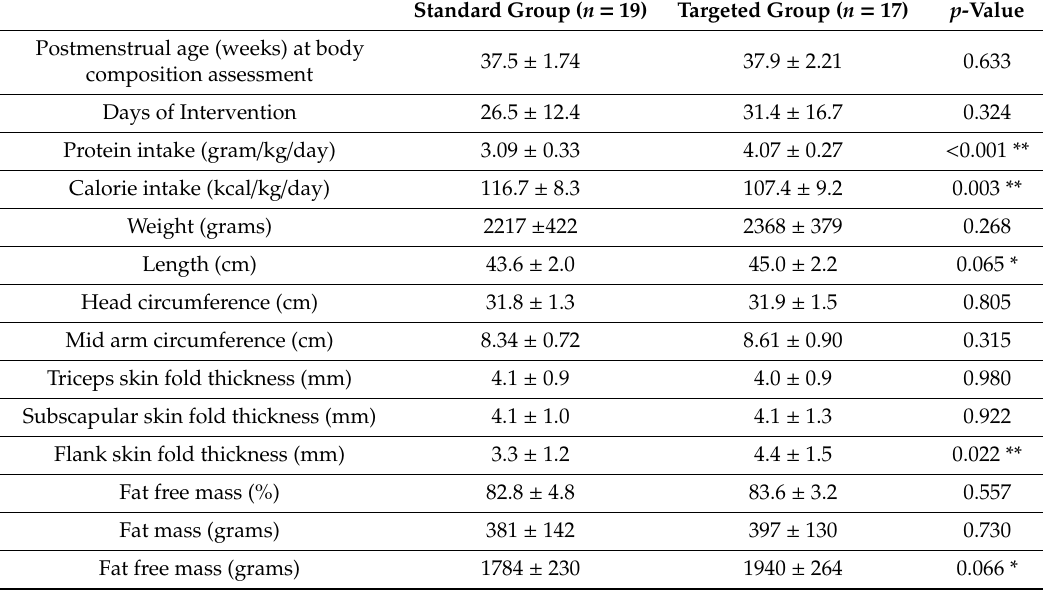
Table 2. Nutritional intake and growth outcomes of the targeted and standard fortification groups ( n = 36) at the end of intervention 1